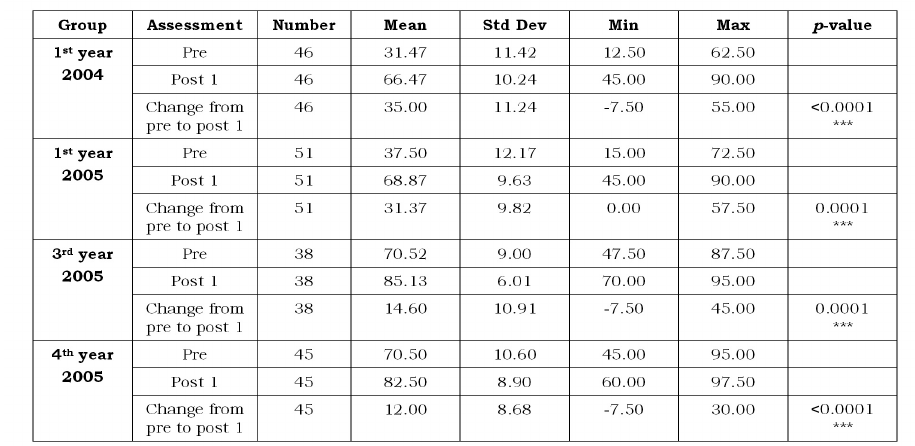
Table 9: Overall percentage knowledge scores of students: study groups 2004 and